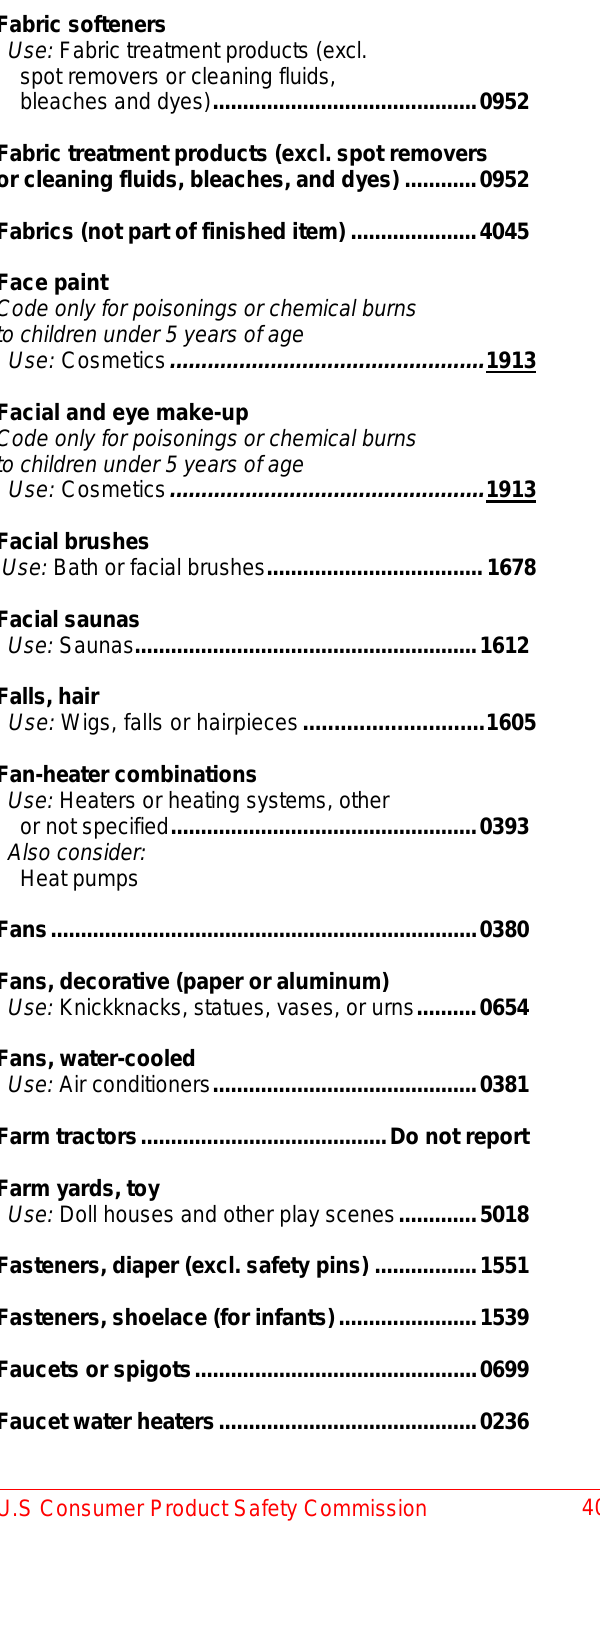
Fabric softeners Use: Fabric treatment products